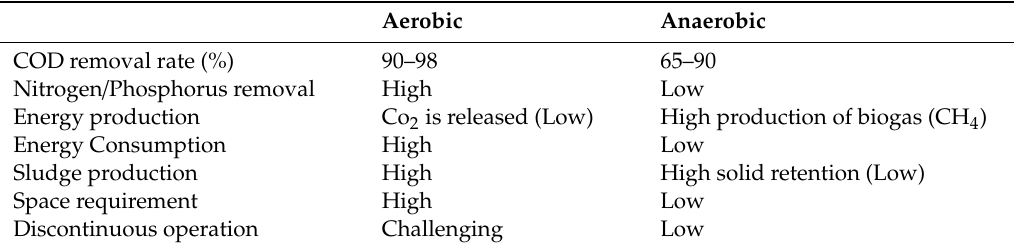
Table 3. Comparison between aerobic and anaerobic